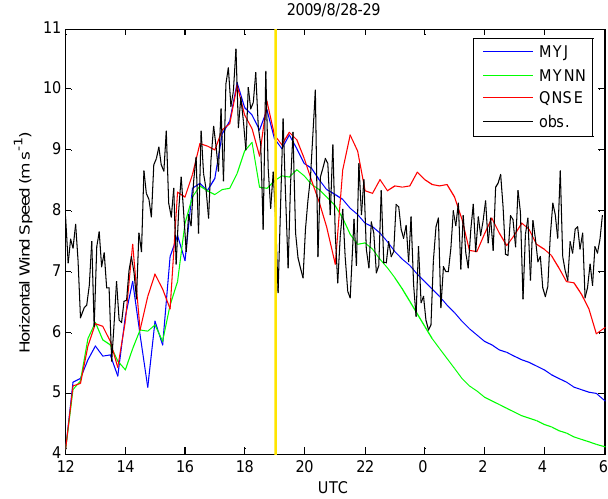
Figure 5. Simulated and observed (5-min averaged) wind speed at 10m for 28–29 August transition (type A).